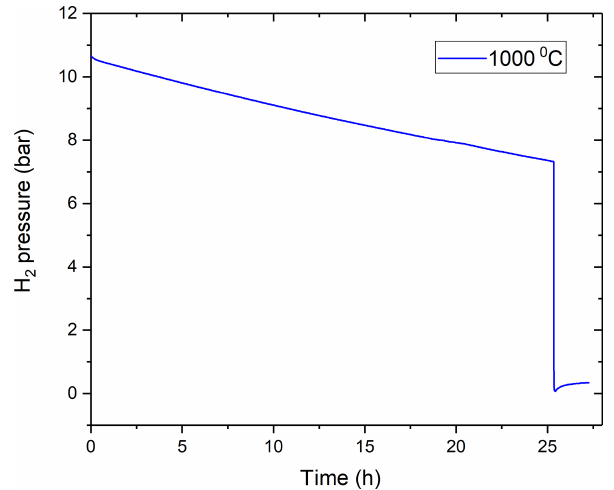
Figure 4. Observation of H 2 pressure loss with time at 1000 ◦ C. It can be noted from the figure that, after vacuuming, the internal pres- sure rose from 0.07 to 0.34bar in almost 2h, which is negligible compared to the total drop of internal pressure during experimental runs. Hence proving the establishment of pseudo-steady-state con-